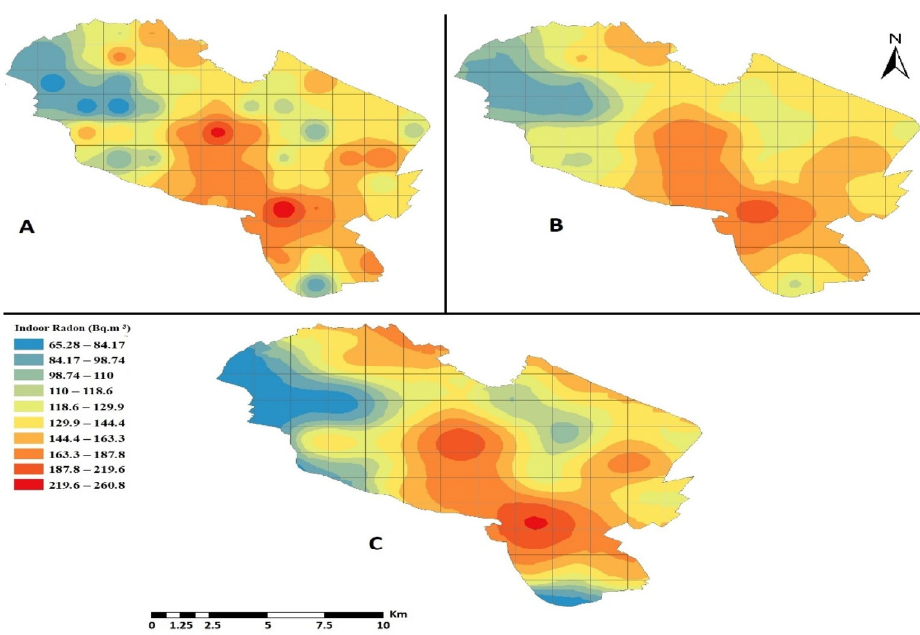
Figure 7. Predicted Indoor Radon Map of Mashhad dwellings over a grid with the dimensions of 1 km × 1 km using the ( A ) Inverse distance weighting, ( B ) Empirical Bayesian Kriging, and ( C ) Ordinary Kriging interpolation